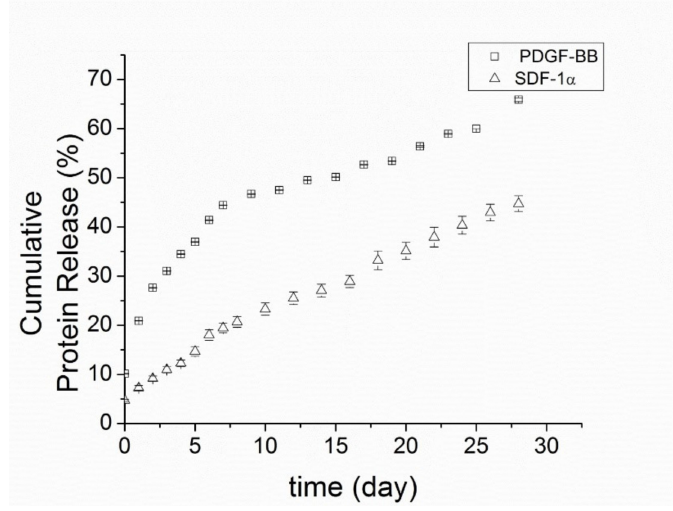
Figure 4. PDGF-BB and SDF-1 α release profile from 2% Gtn-HPA